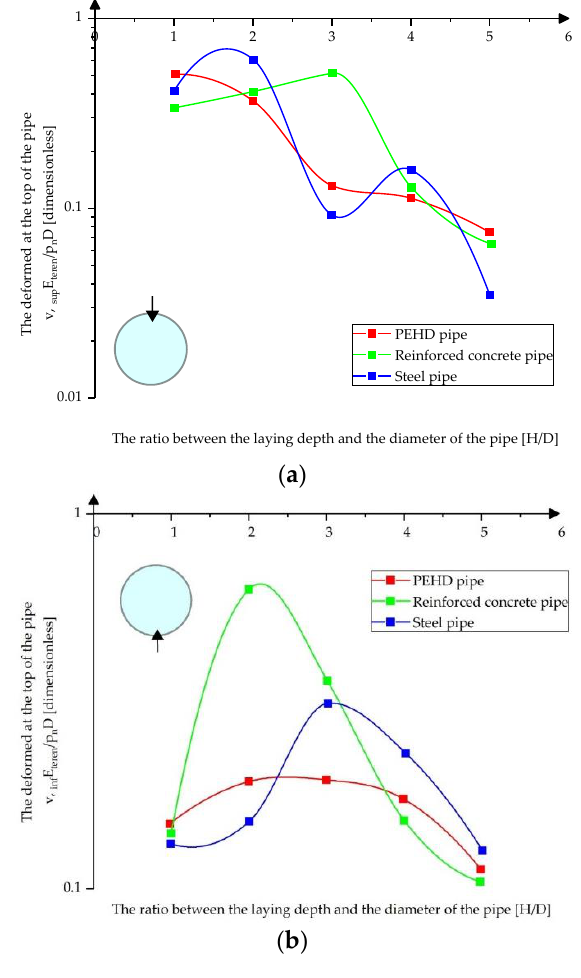
Figure 14. Absolute displacement variation in compacted clay ( a ) at the top of the pipes ( b ) at the bottom of the pipes